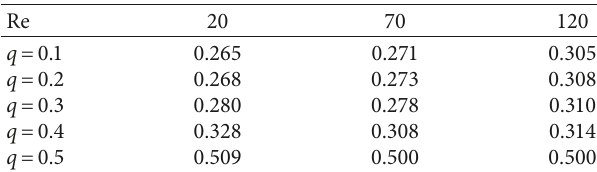
Table 2: Dependence of the final equilibrium position on Re as well as q .